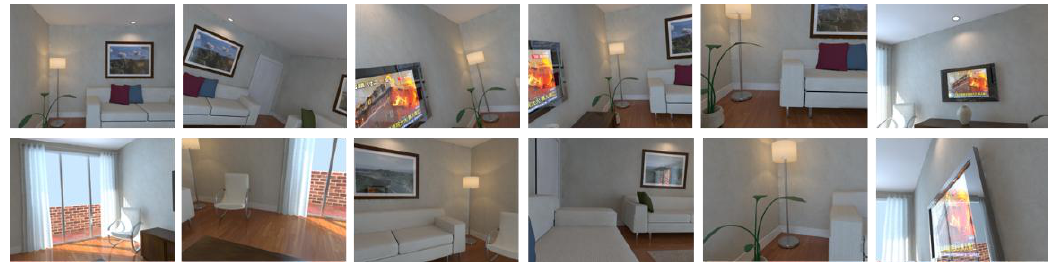
Figure 6. Images in office room scene of ICL-NUIM dataset.